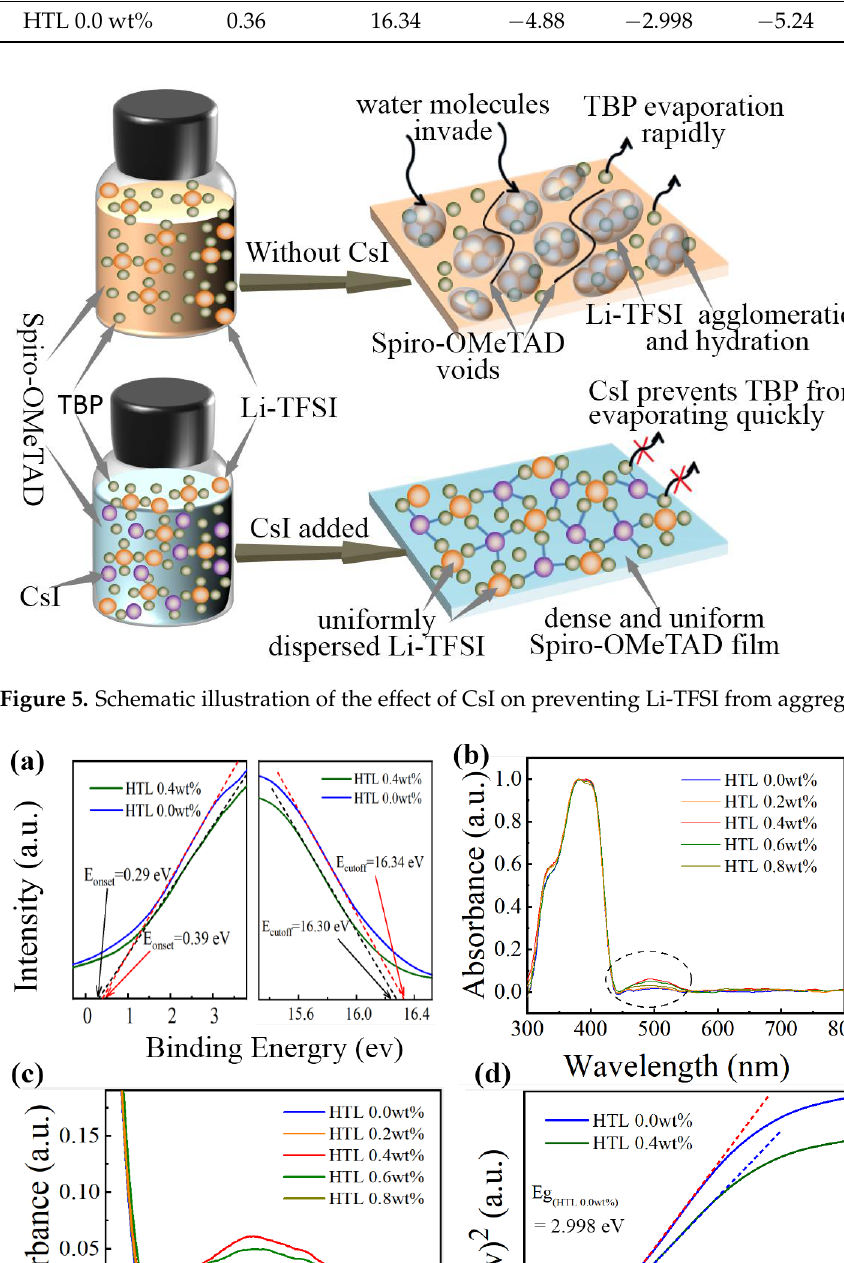
Figure 7. ( a ) Energy levels of the perovskite, HTL 0.0 wt% and HTL 0.4 wt% layers. ( b ) PL spectra of perovskite and perovskite/Spiro-OMeTAD with different concentrations of CsI. ( c ) Time-resolved